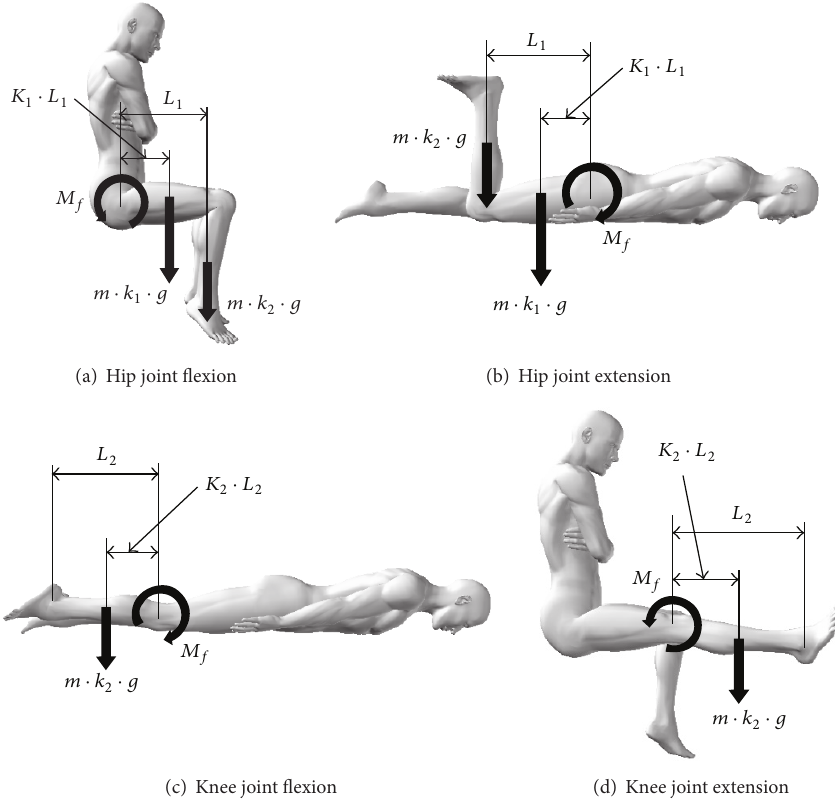
Figure 2: Calculating 𝑀 𝑓 . 𝑚 : body weight (kg), 𝑔 : acceleration due to gravity (m/s 2 ) = 9.8, 𝐿 1 : thigh length (m), 𝑘 1 : thigh weighting factor (men: 0.1; women: 0.1115), 𝐾 1 : thigh center of gravity distance ratio = 0.42, 𝑘 2 : lower leg and foot combined weighting factor (men: 0.0725; women: 0.0685), 𝐾 2 : lower leg and foot combined center of gravity distance ratio = 0.51, and 𝐿 2 : lower leg length